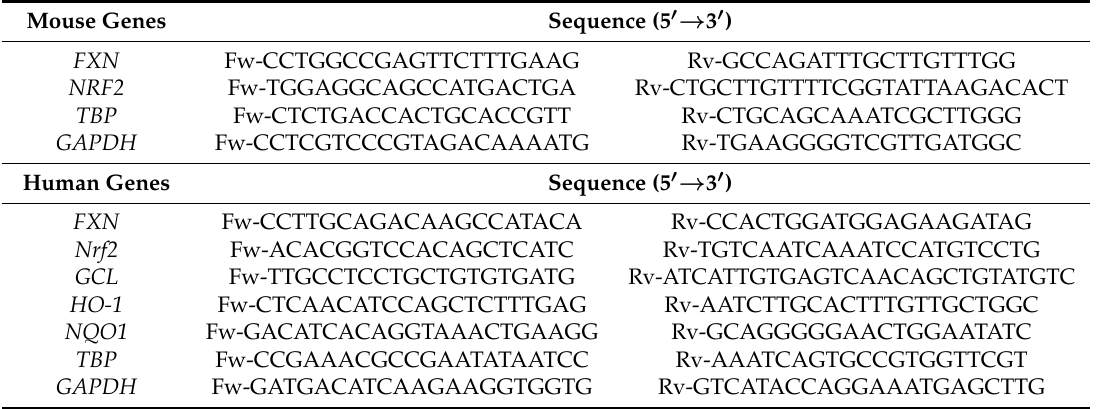
Table 2. Primers used for